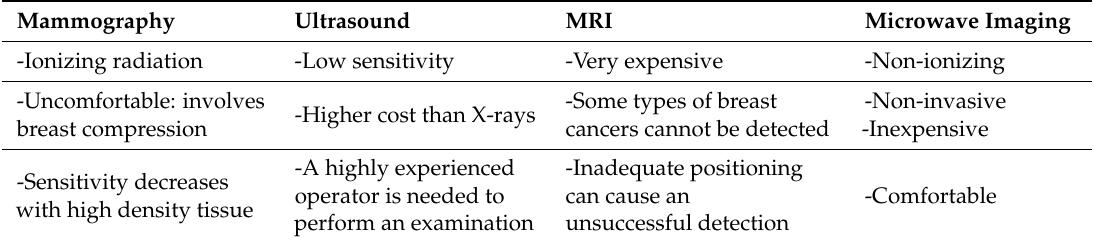
Table 1. A comparison between microwave imaging (MI) and other breast cancer detection techniques.